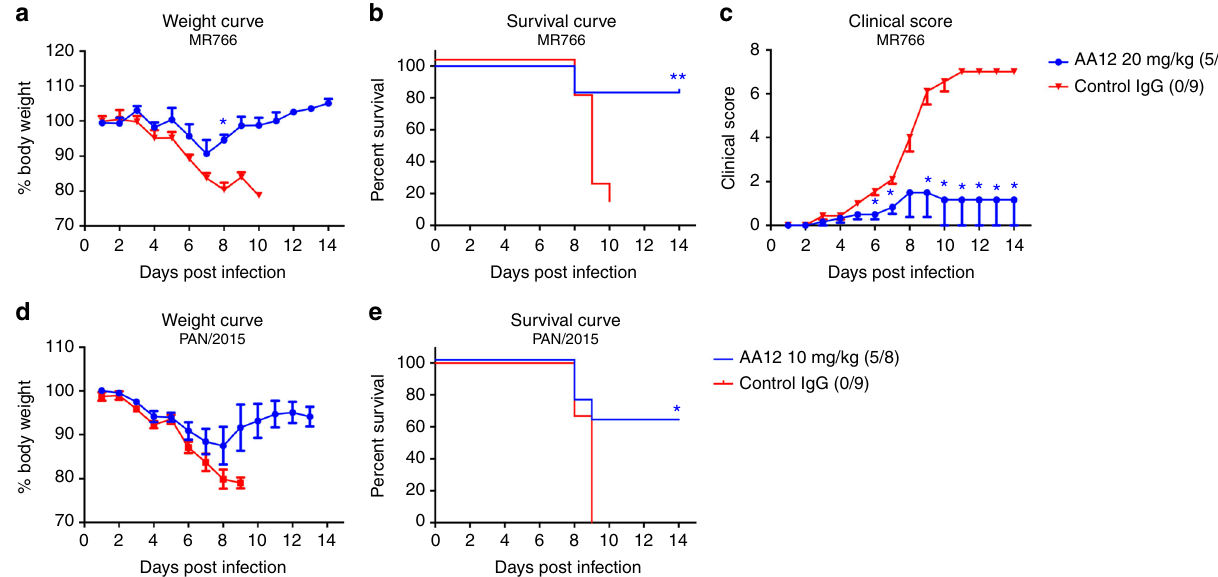
Fig. 4 NS1-speci fi c antibodies protect mice against lethal challenge in vivo. a – c Groups of 6 – 9 male and female B6.129-Stat2 -/- mice were injected IP with 20 mg per kg of AA12 before a challenge with 10 mLD 50 of ZIKV MR766 intradermally. A mAb (CR9114) against in fl uenza A virus was used as an IgG control. d , e Mice were treated with 10 mg per kg of AA12 or 10 mg per kg of isotype control before a challenge with 500 PFU of ZIKV PAN/2015 retro- orbitally. Weight loss was monitored daily. For mice infected with ZIKV MR766, clinical scoring was conducted using the pre-de fi ned criteria with a maximum possible score of 7: impact on walking (1), unresponsiveness (1), left hind leg paralyzed (1), right hind leg paralyzed (1), left front leg paralyzed (1), and right front leg paralyzed (1). Deceased animals were awarded a score of 7. The ratios in the fi gures indicate the number of animals that survived challenge over total number of animals per group. Murine challenge studies were performed as two independent replicates with at least three mice per treatment group and data shown here were pooled. The Mantel-Cox and Gehan-Breslow-Wilcoxon tests were used to analyze statistical signi fi cance of survival between two groups. A multiple t -test and the Holm-Sidak method were used to determine statistical signi fi cance at each time point for the weight curve and the clinical score. Asterisk(s) indicates statistical signi fi cance of a group (* p < 0.05 and ** p < 0.005) compared to control IgG. No signi fi cant differences between groups were detected in